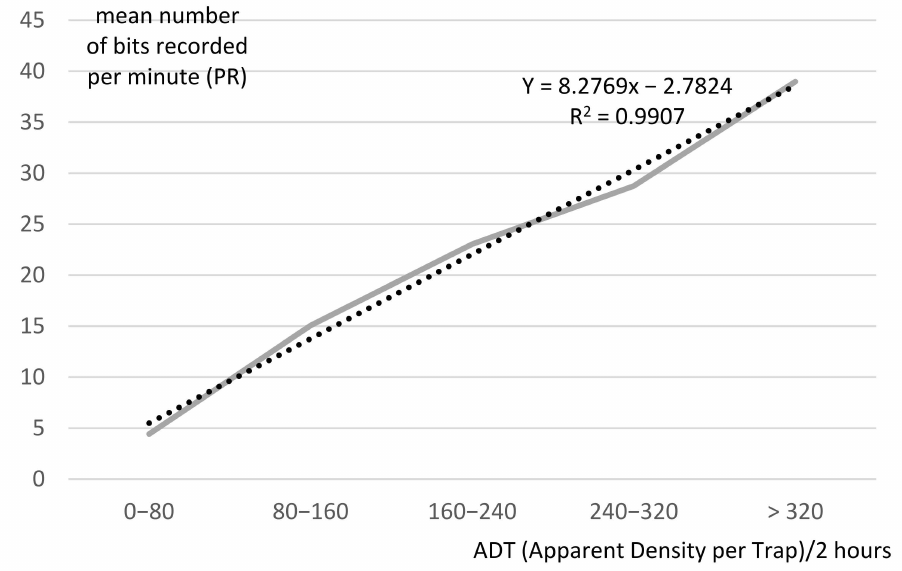
Figure 7. Pedometer record frequencies (bits/minute) in function of the ADT/2 h of hematophagous